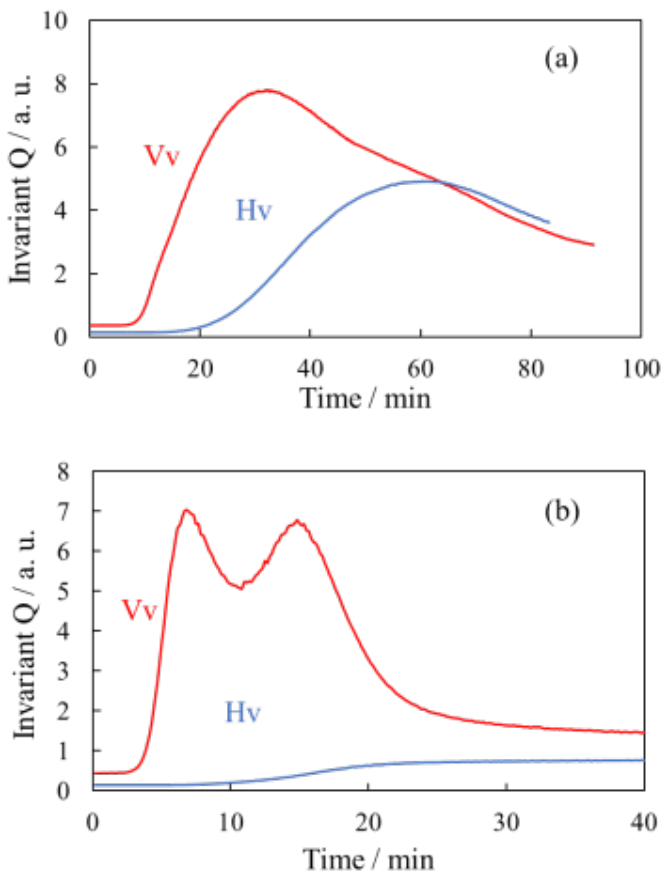
Figure 7. Time evolutions of invariant Q Hv and Q Vv during isothermal crystallization at 165 ◦ C: ( a ) α -spherulite of neat PVDF; ( b ) γ -spherulite of